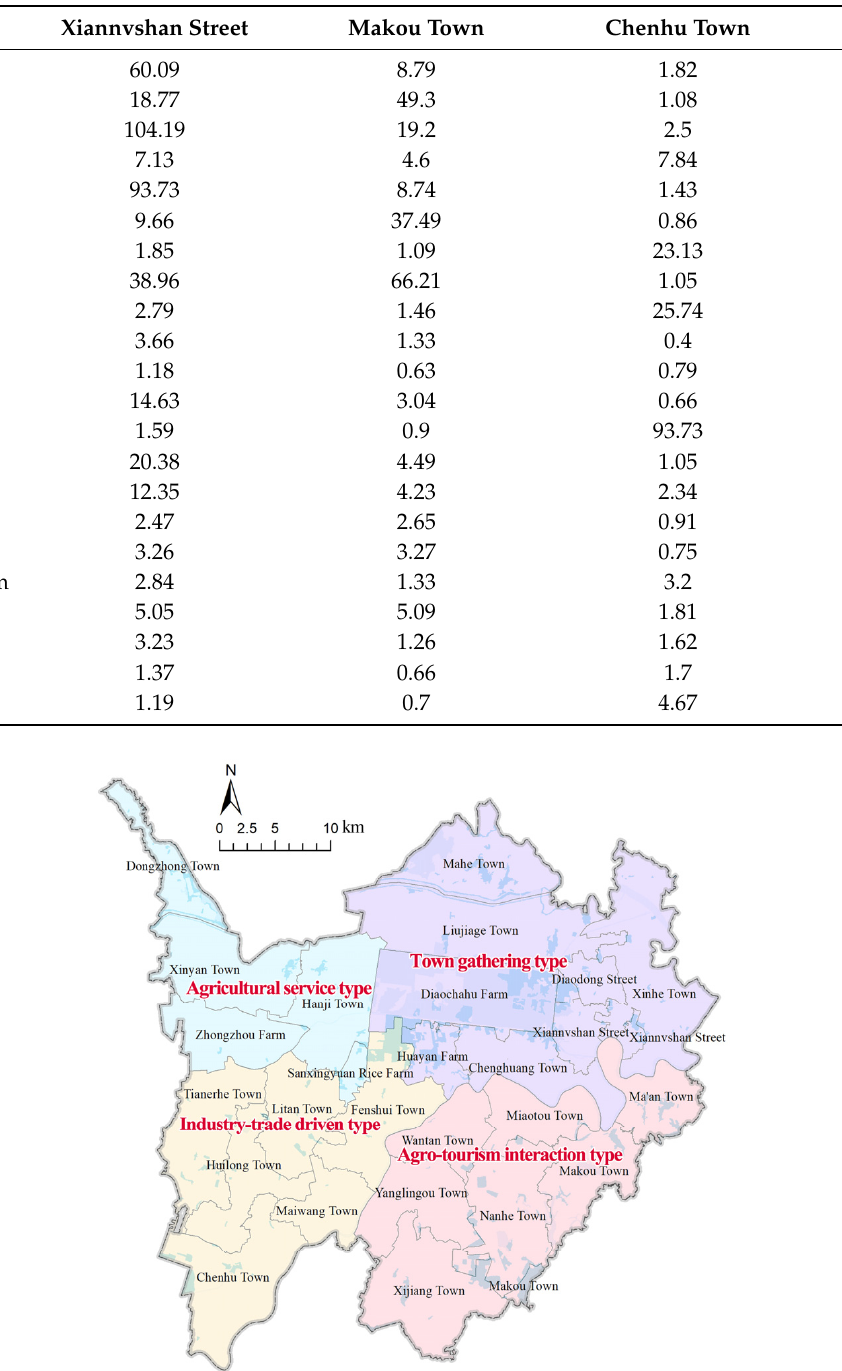
Figure 7. Spatial distribution of the urban–rural integration development pattern.